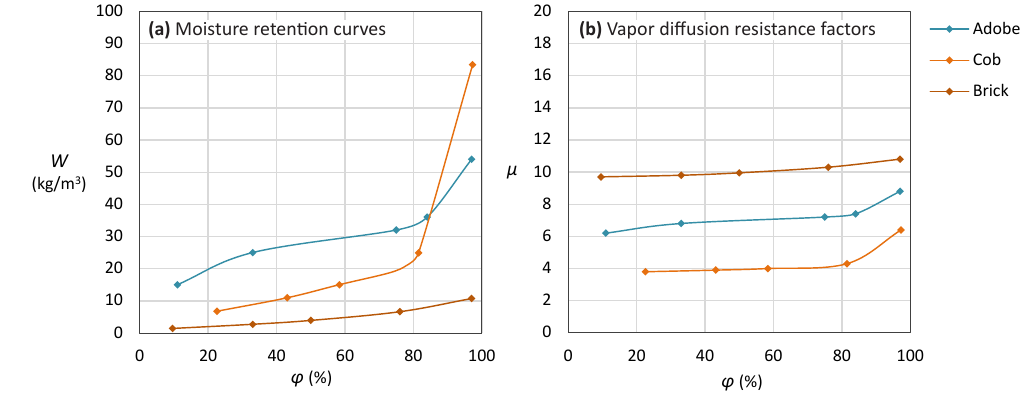
Figure 7. Adobe properties, as well as those of cob and unfired earth bricks discussed below, used in estimating intrinsic evaporative cooling behavior: ( a ) moisture retention curves W and ( b ) vapor diffusion resistance factors µ calculated using Equation (8) [46]. Adobe properties follow